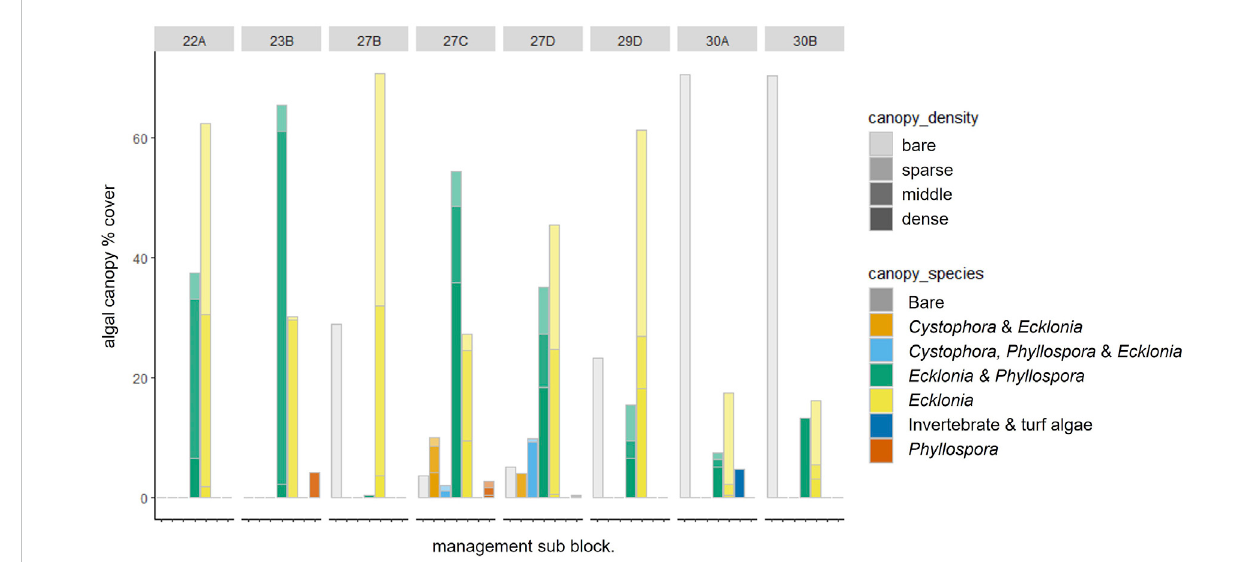
FIGURE 6 Mean% cover of different algal canopy species at different densities across abalone management sub blocks. Bare = no algae, sparse = 0 – 20%, middle 20% – 60%, dense = > 60% cover.